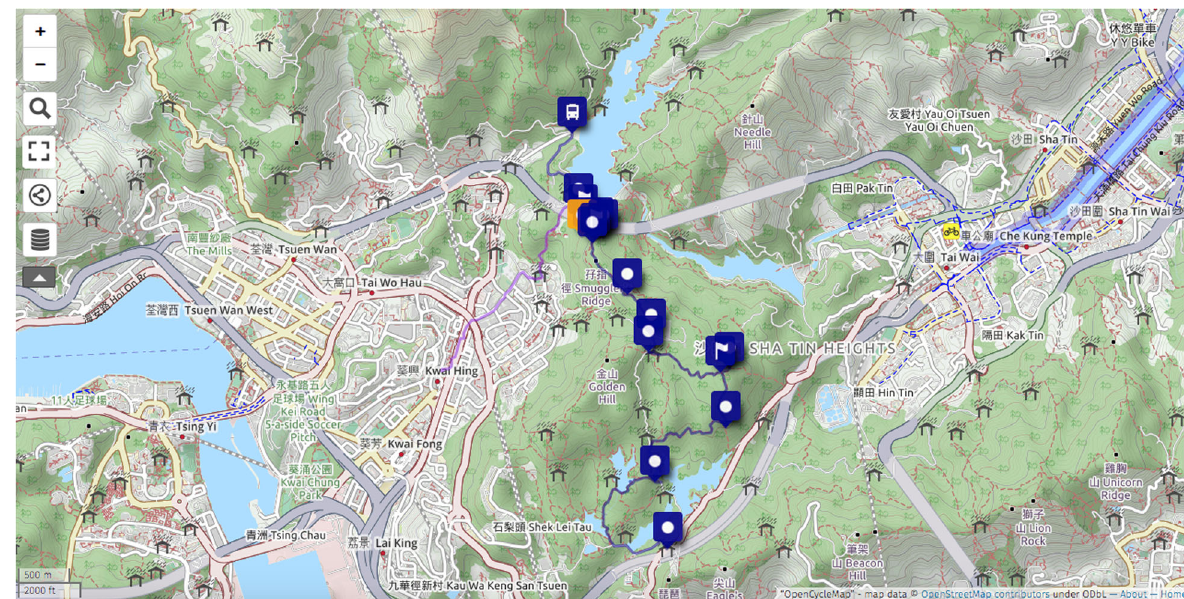
Fig. 8 Section of the Gin Drinkers ’ Line in the New Territories with hiking information (Source: